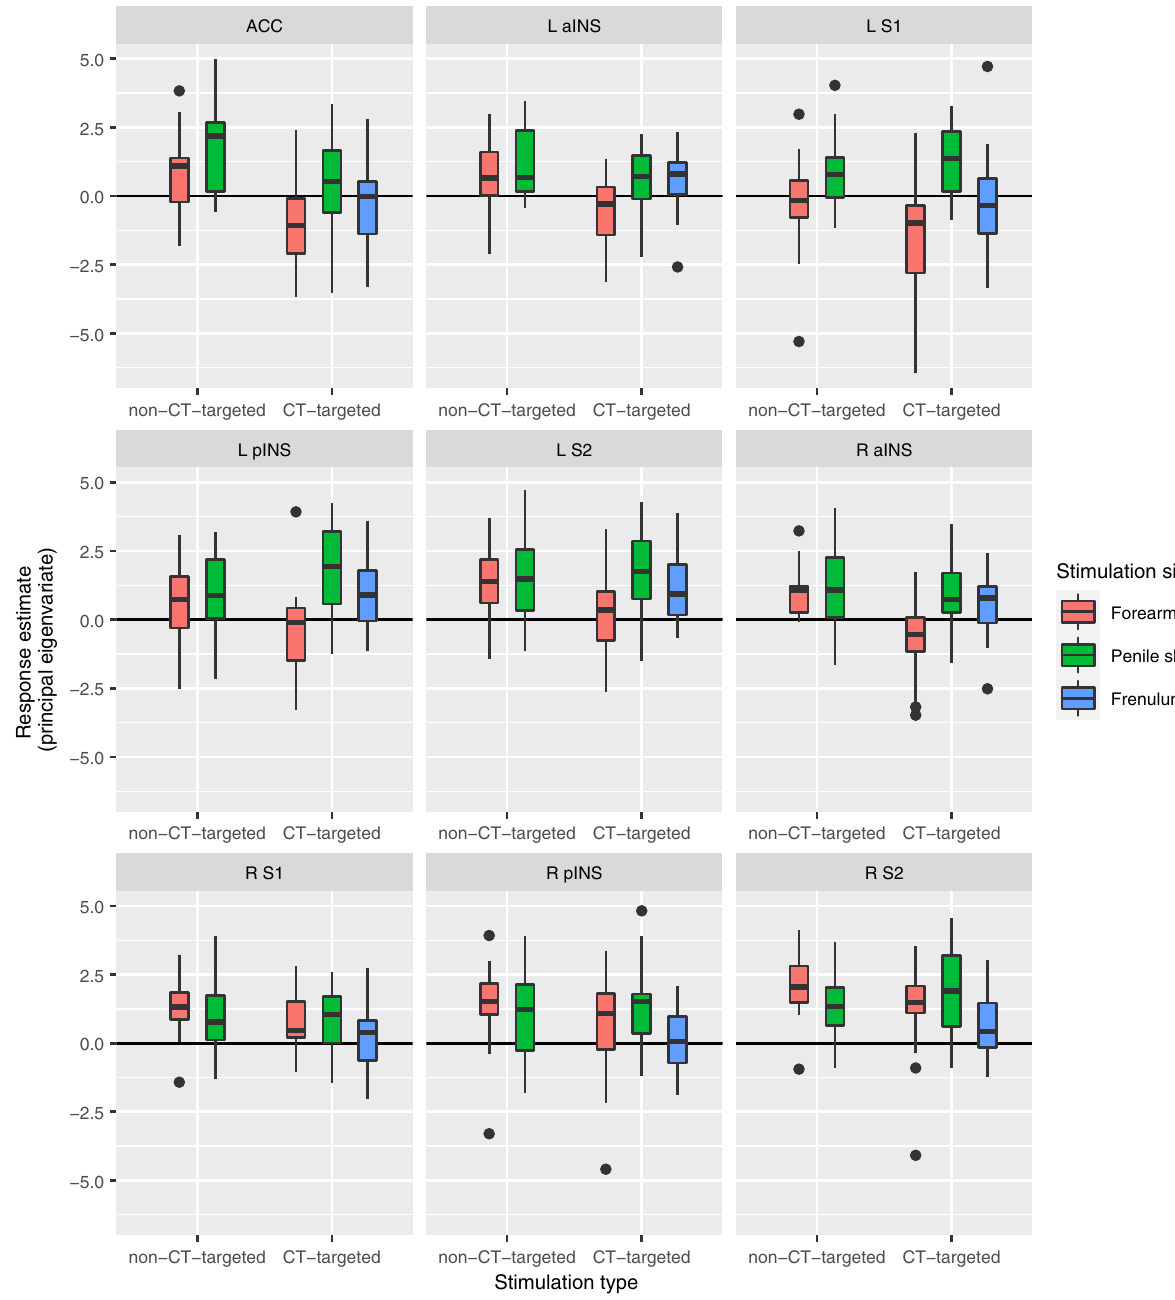
Figure 4. Boxplots of response estimates (principal eigenvariate) for each dynamic stimulation condition for core somatosensory areas. Abbreviations: primary somatosensory cortex (S1), secondary somatosensory cortex (S2), (bilateral) anterior cingulate cortex (ACC), posterior insula (pINS), anterior insula (aINS). Figure was created using ggplot2 (v. 3.3.2; https:// ggplo t2. tidyv erse. org/) within RStudio (v. 1.4.1106; https:// www. rstud io. com/)